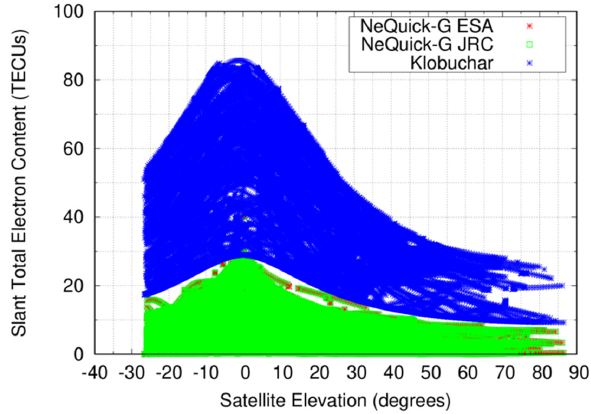
Figure 3. STECs for a receiver on-board a COSMIC-2 satellite.